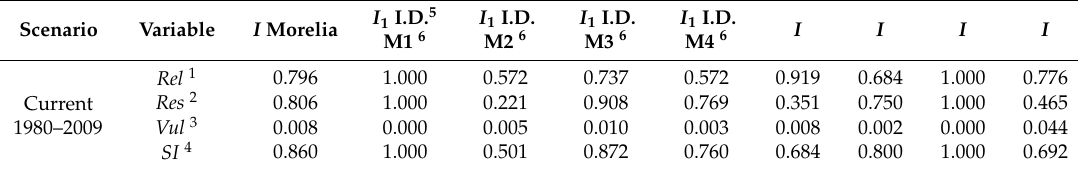
Table 3. Reliability, resilience, and vulnerability and SI index I 2 , I 3 , I 4 , and I 5 for the current